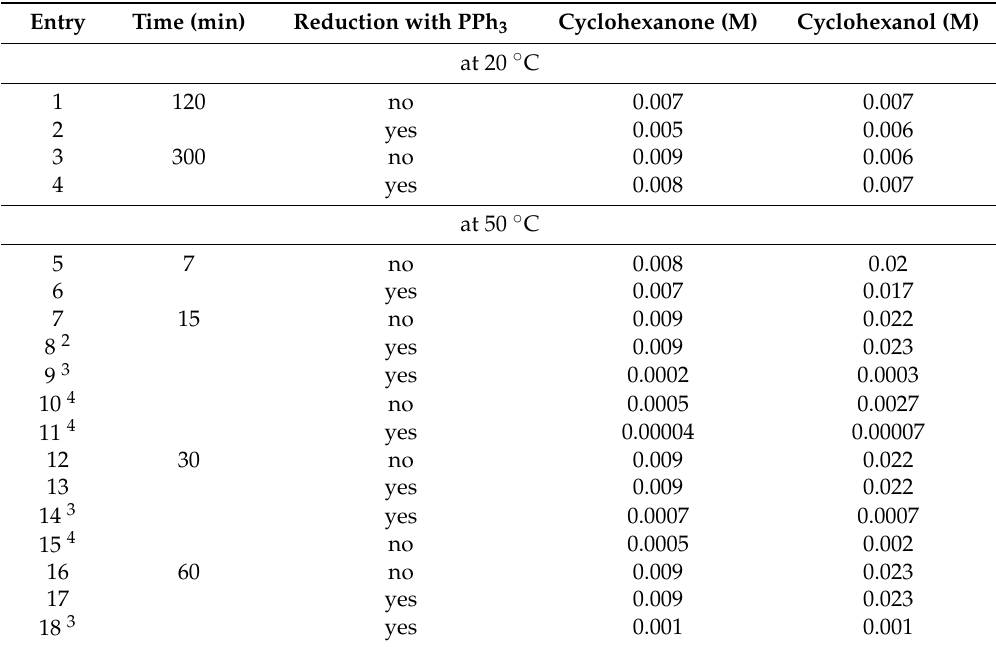
Table 1. Oxidation of cyclohexane with m -CPBA catalyzed by complex 1 1 .